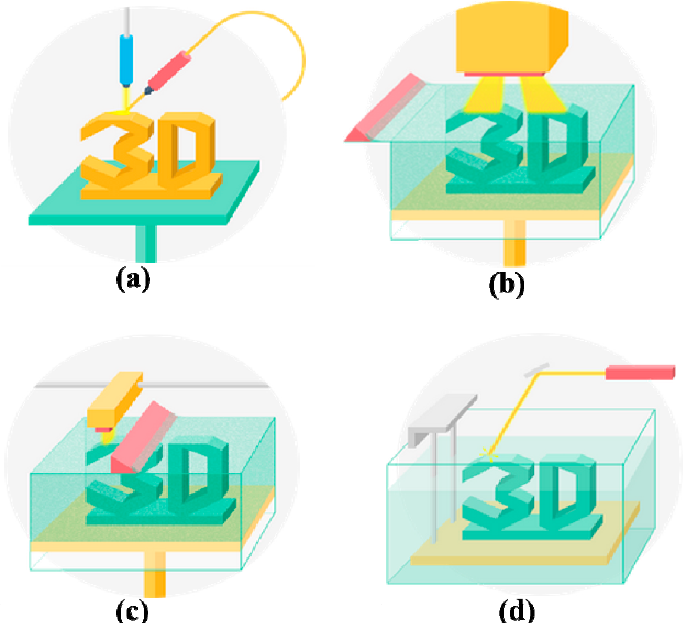
Figure 3. Schematic depiction of various stereolithography (SLA) technologies: ( a ) laser sintering; ( b ) two-photonpolymerization (TPP); ( c ) powder bed fusion; ( d ) vat photopolymerization.